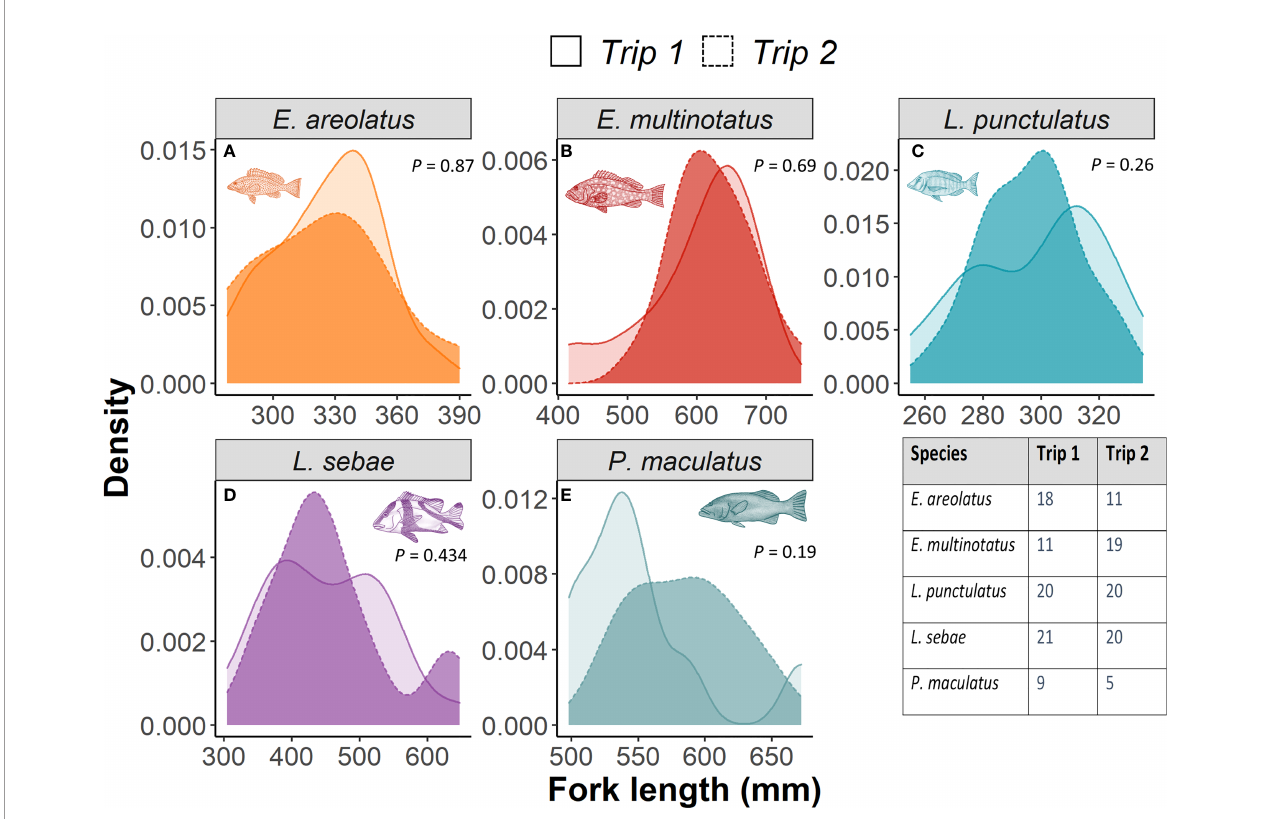
FIGURE 4 | A comparison of kernel density distributions for fork length of each fi sh species between trips. P values represent KS test result for signi fi cance. The table inset provides number of individuals measured for each